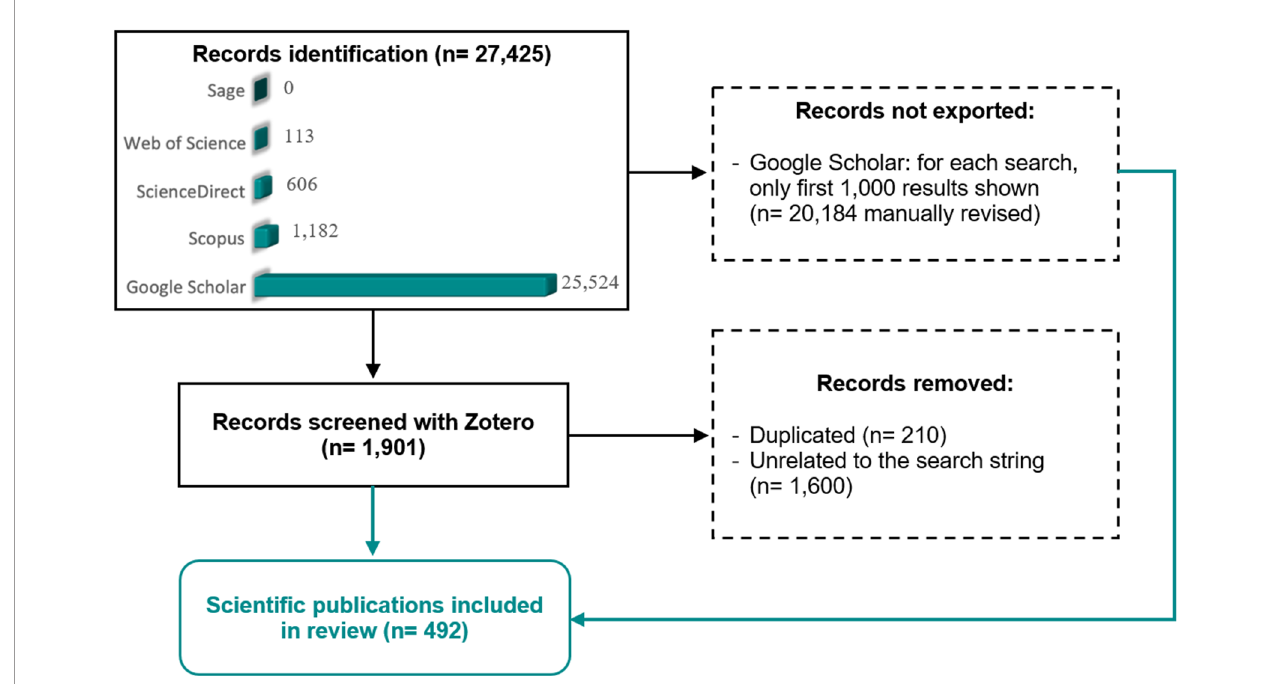
FIGURE 1 | Flow diagram of the methodology used in the literature search performed in this systematic review. Adaptation from PRISMA (Preferred Reporting Items for Systematic Reviews) template (Page et al.,